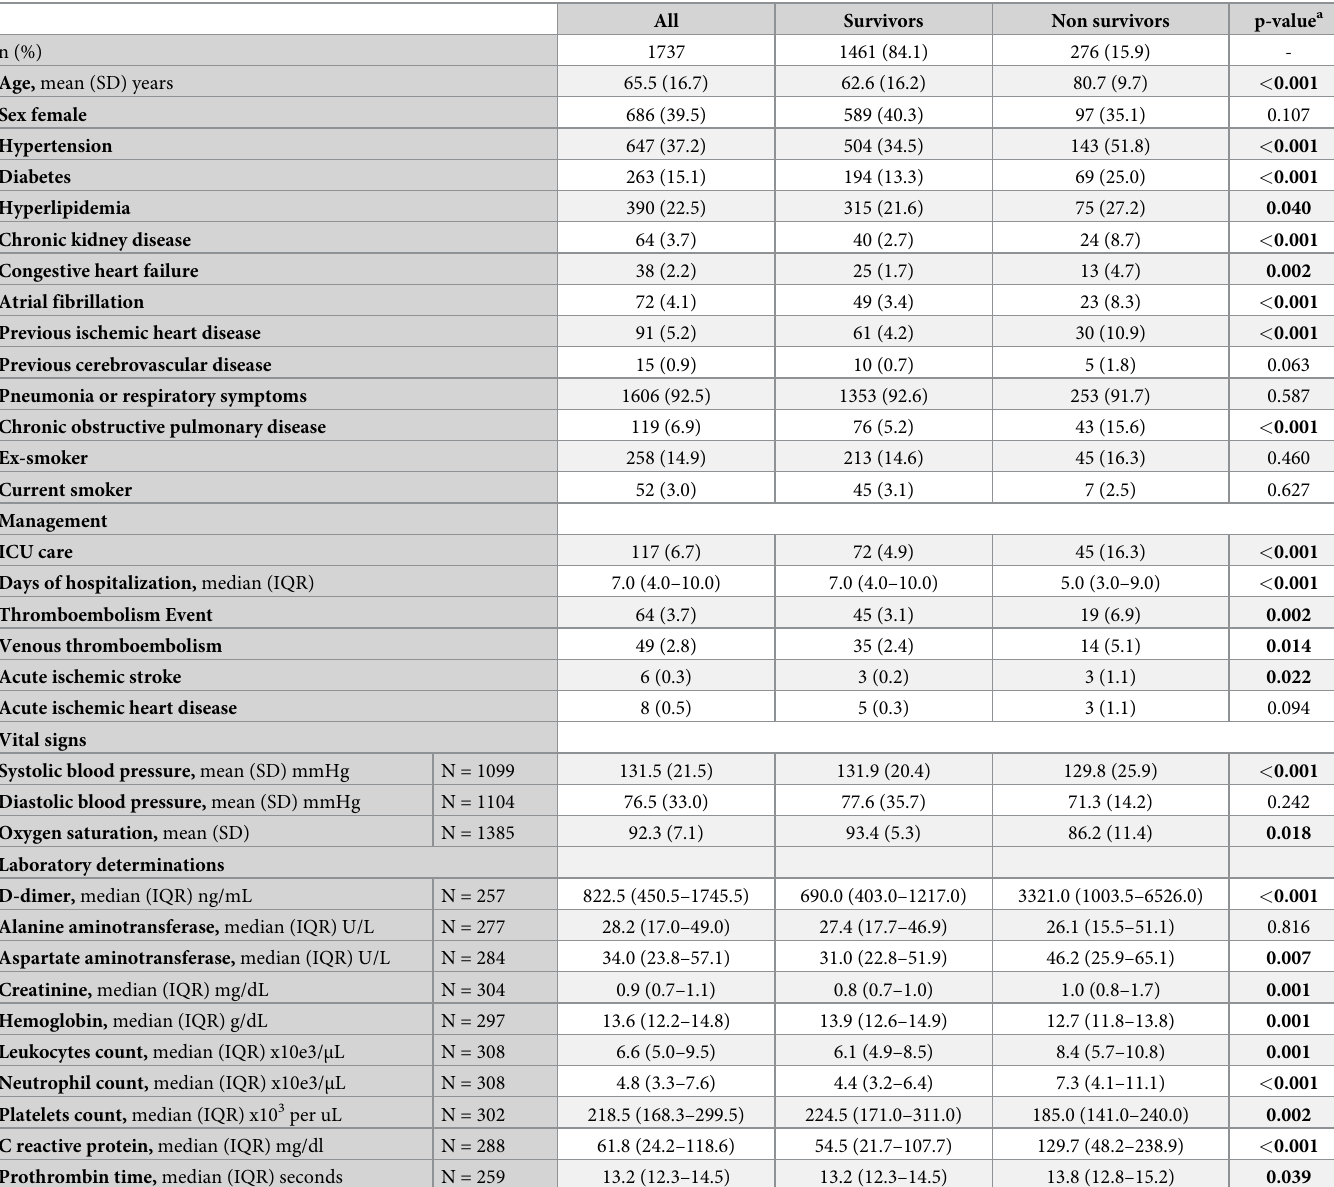
Table 2. Demographic and clinical findings among COVID-19 patients with thromboembolic events, stratified by mortality.